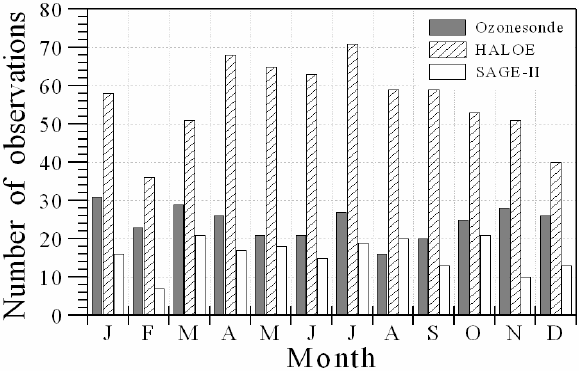
Fig. 1. Histogram represents the monthly distribution of Histogram represents the monthly distribution of Ozonesonde, HALOE and SAGE-II ozonesonde, HALOE and SAGE-II satellite data used for the satellite data used for the present study and for the period from 1992 to 2005. present study and for the period from 1992 to